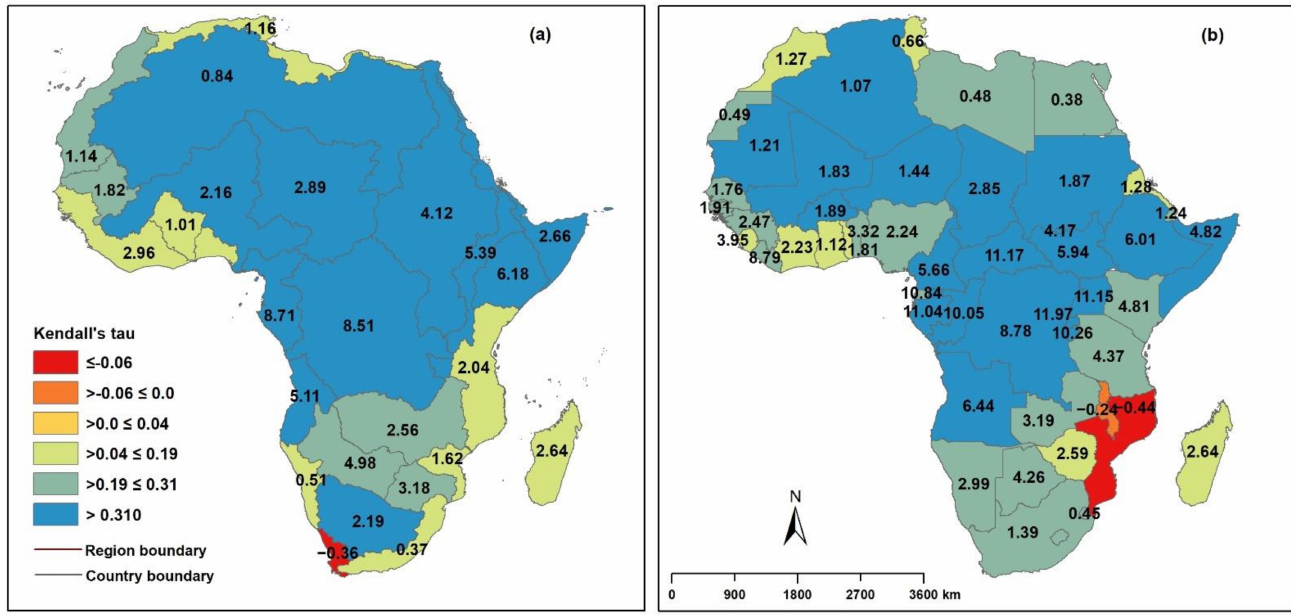
Figure 11. Annual rainfall trend with Kendall’s Tau (colour gradient) and Sen’s slope (numbers) between 1983 and 2020. ( a ) major river basins, and ( b ) countries of Africa.